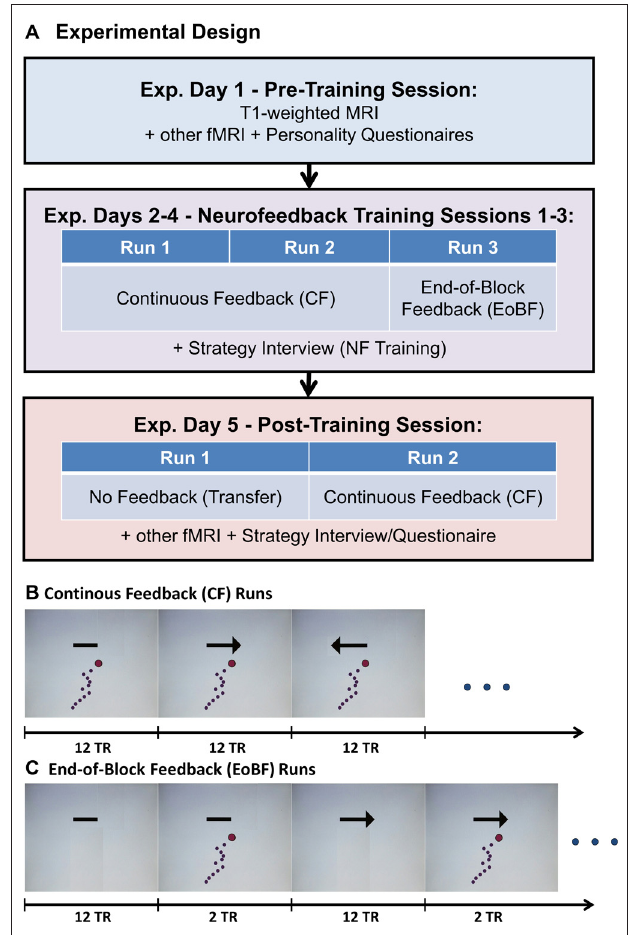
FIGURE 1 | (A) Experimental design. Each of the three feedback training sessions consisted of two runs with continuous feedback (B) followed by one run with end-of-block feedback (EoBF; C ). The feedback display, shown in (B) and (C) , is updated every TR. The arrow indicates the regulation direction, which is linked to “UP”- or “DOWN”-regulation of the amygdala in a counter-balanced fashion. A simple bar without arrow head indicates a rest period. Regulation or rest periods were 12 TR (cid:117) 30 s in length ( TR = 2.54 s). All runs began with a rest block followed by 8 blocks each of left regulation, right regulation, or rest. The dots mark the amygdala signal from the last 12 fMRI image acquisitions. The red dot represents the most recently acquired data, while the purple dots represent progressively older